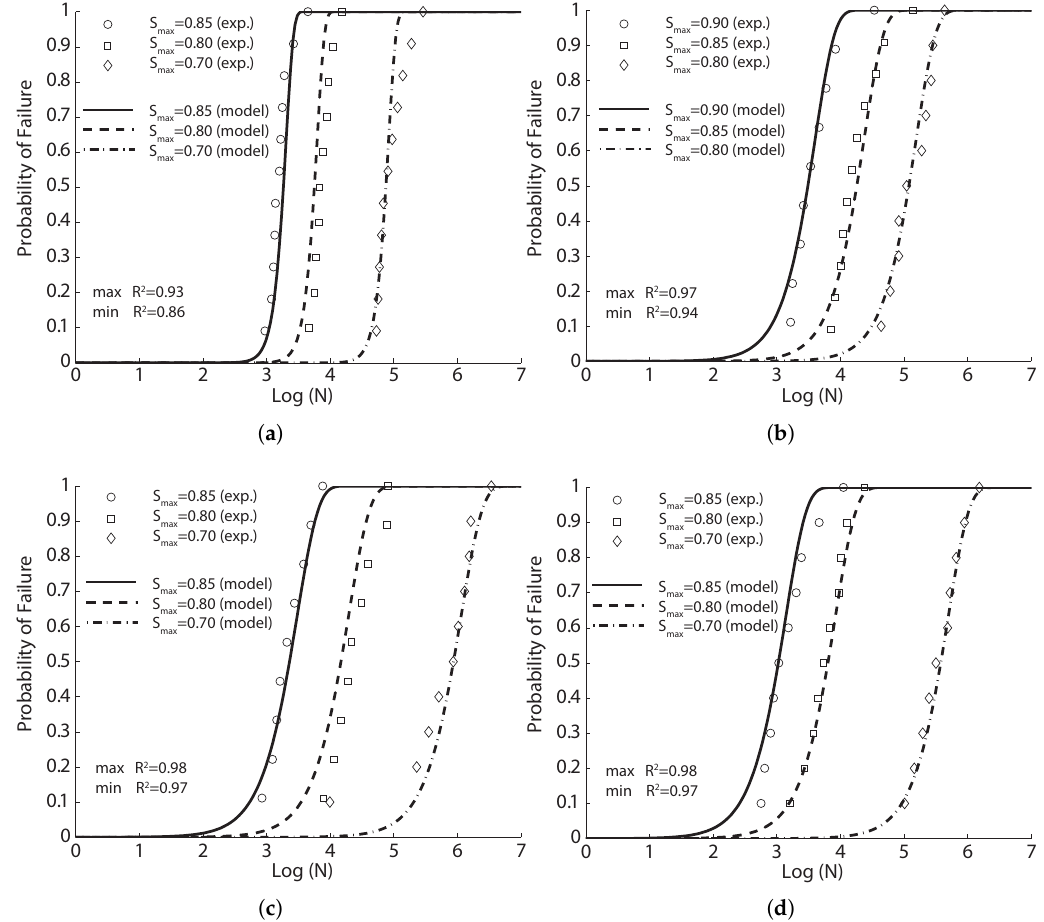
Figure 8. Comparison of the flexural fatigue data of Mohammadi and Kaushik [17] with the fitted probabilistic model Equation (8) for concrete reinforced with fibers of 25 mm in length and volume ratios of ( a ) 0%; ( b ) 1%; ( c ) 1.5% and ( d )